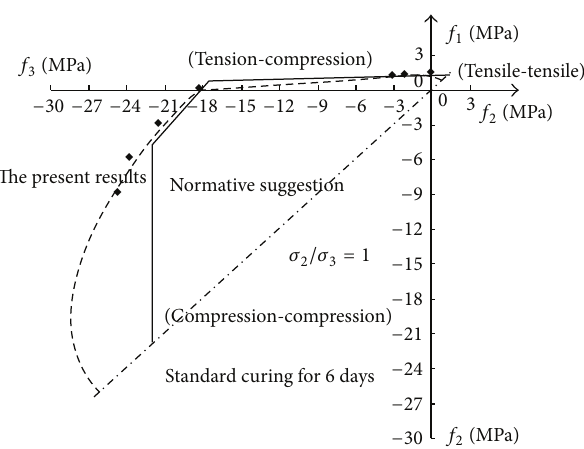
Figure 10: Biaxial ultimate strength envelope diagram of the C20 concrete after 6d of standard curing.